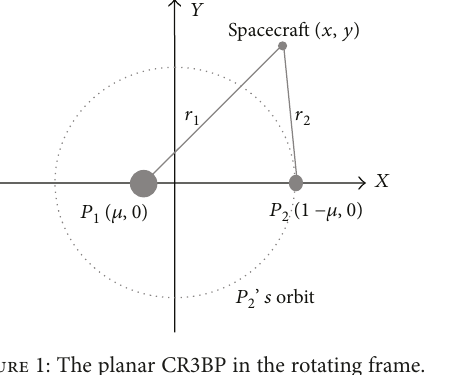
Figure 1: The planar CR3BP in the rotating frame.